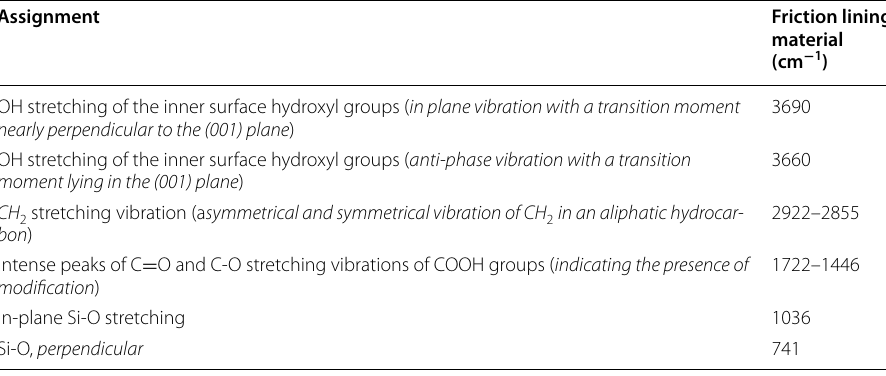
Table 9 Absorption bands in the FTIR spectra of friction lining material position and assignment Assignment Friction lining